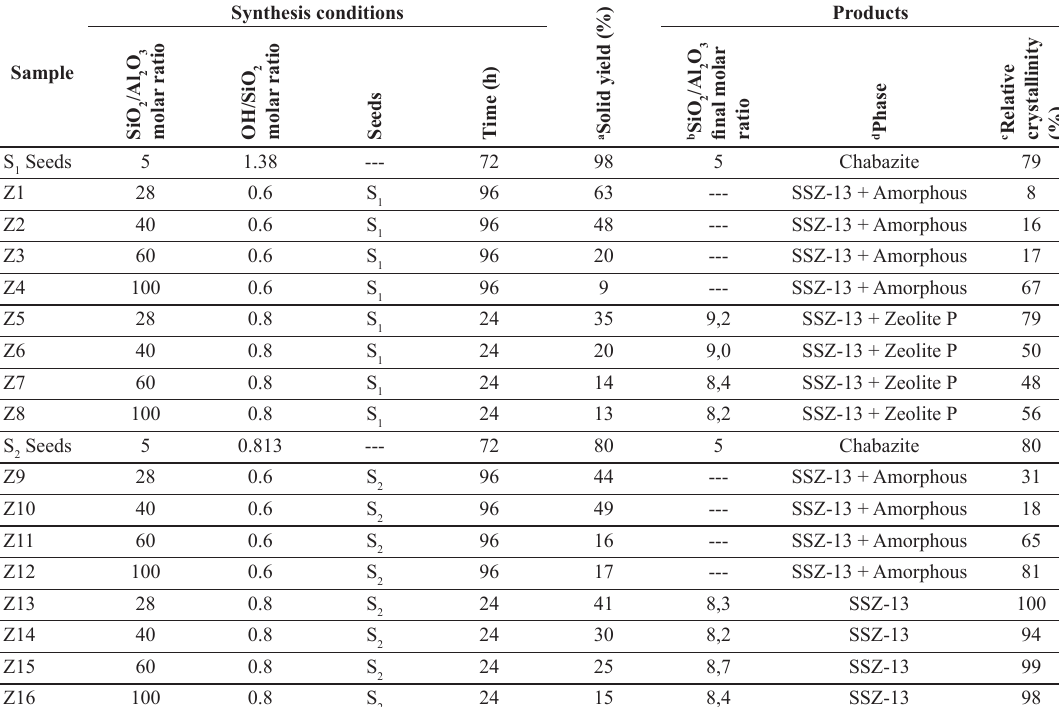
Table 1. Synthesis and characterization results (XRD and